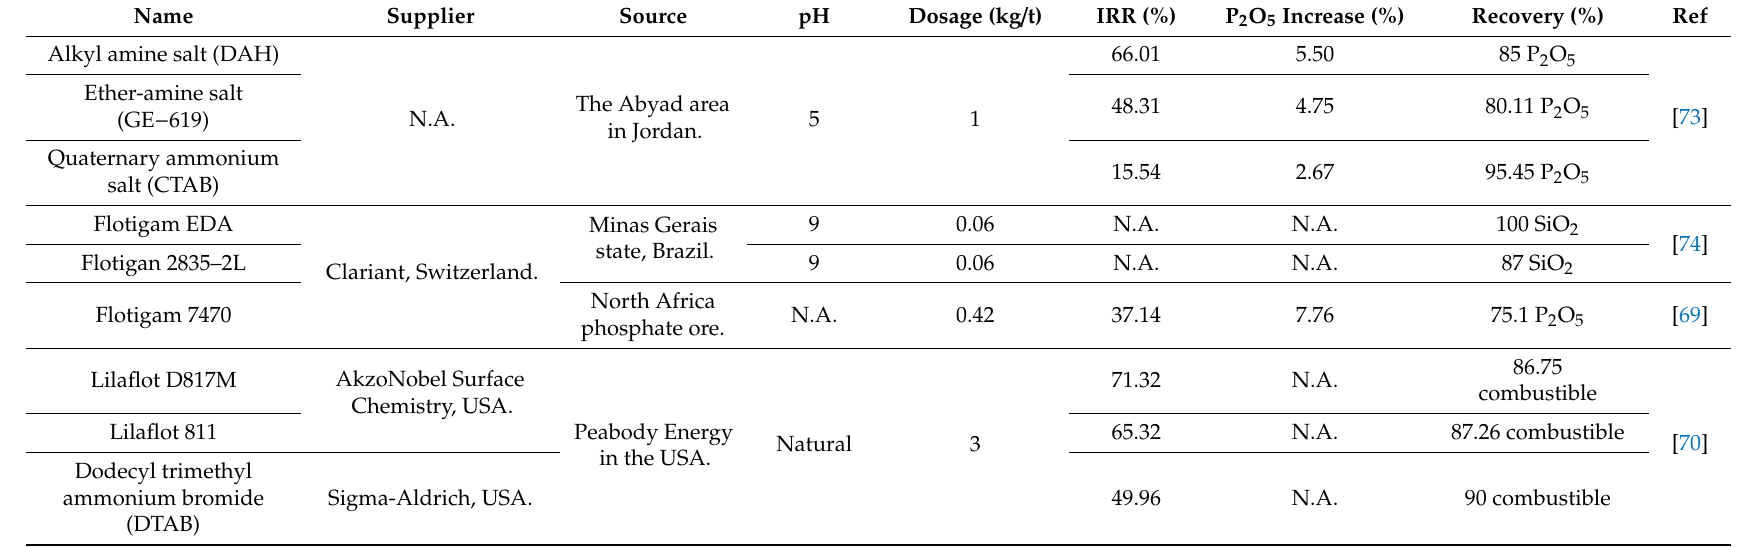
Table 11. Cationic collectors used for the selective flotation of silica